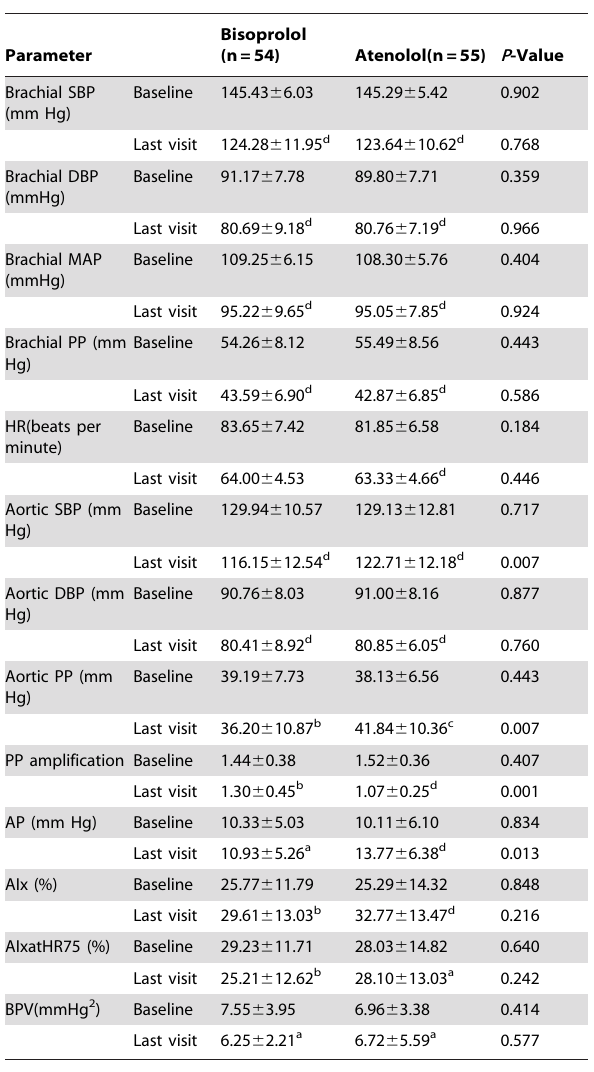
Table 2. Comparison of changes in hemodynamic variables from baseline to the end of treatment in the bisoprolol and atenolol groups